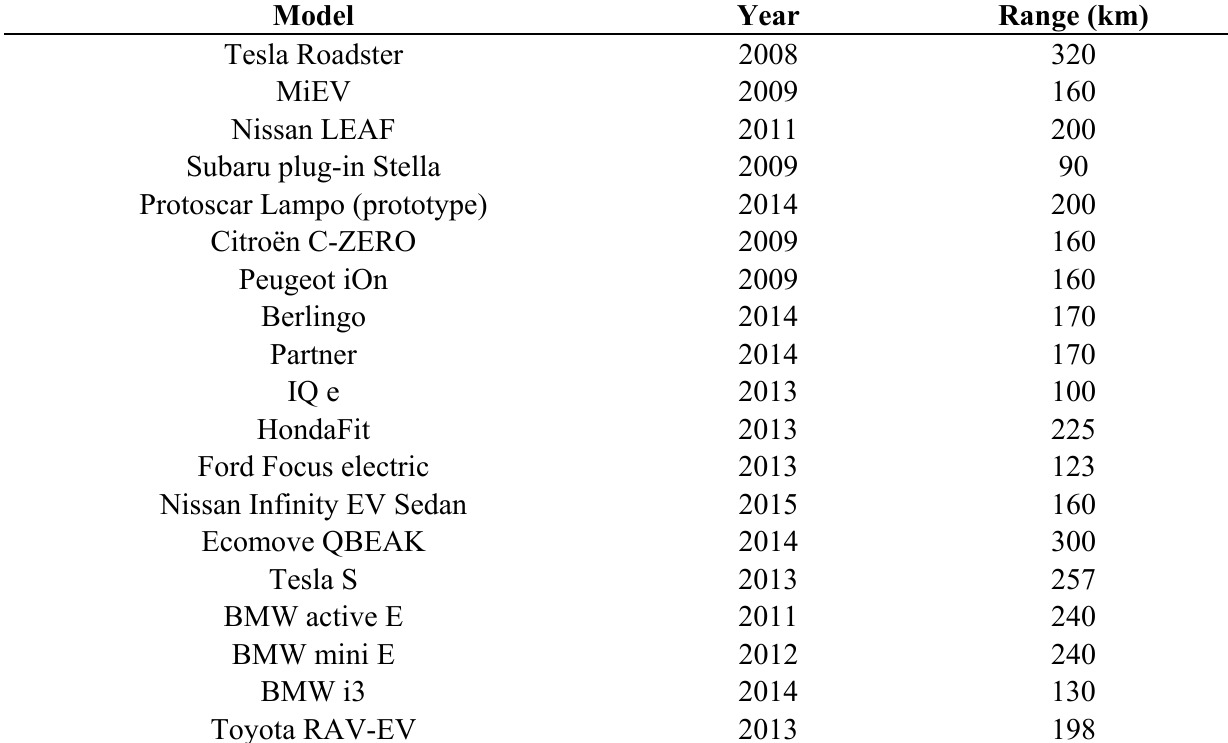
Table 1. Fast charge enabled EV models, year and range. Based on manufacturer’s public